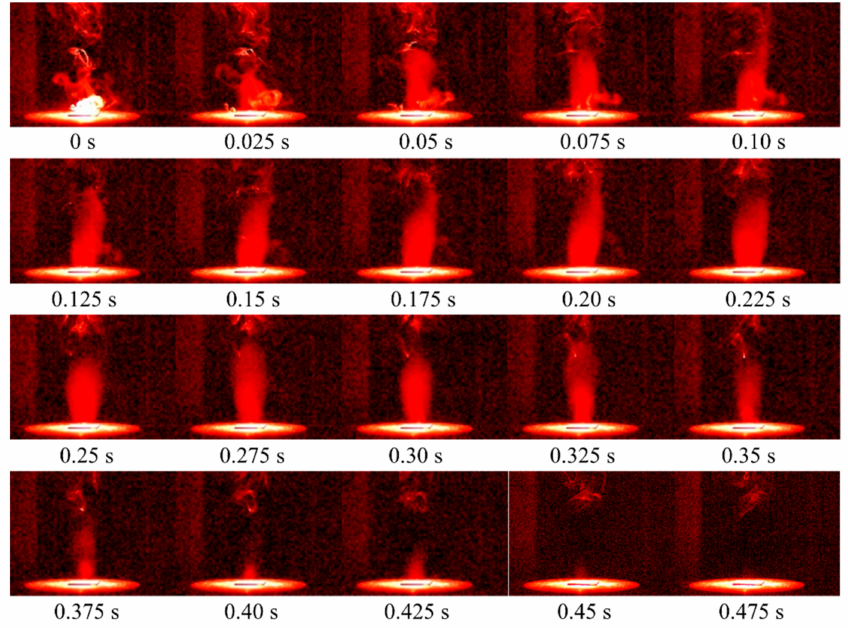
Figure 4. Flame development of RDX at 298